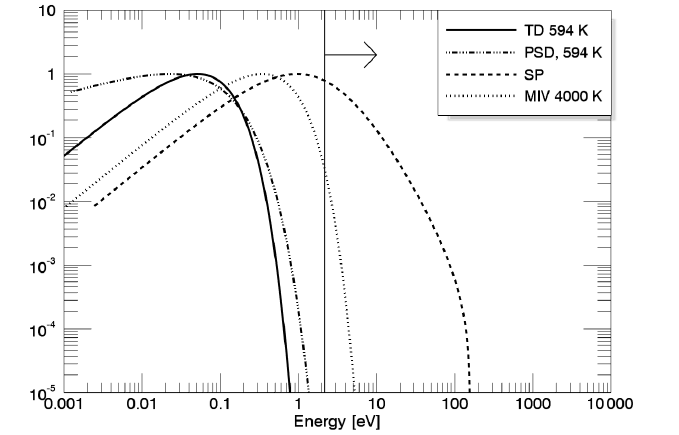
Table 1. Parameters for